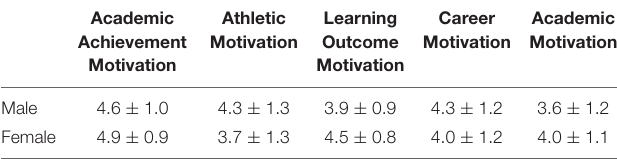
TABLE 6 | Mean and standard deviation values for motivation scores by